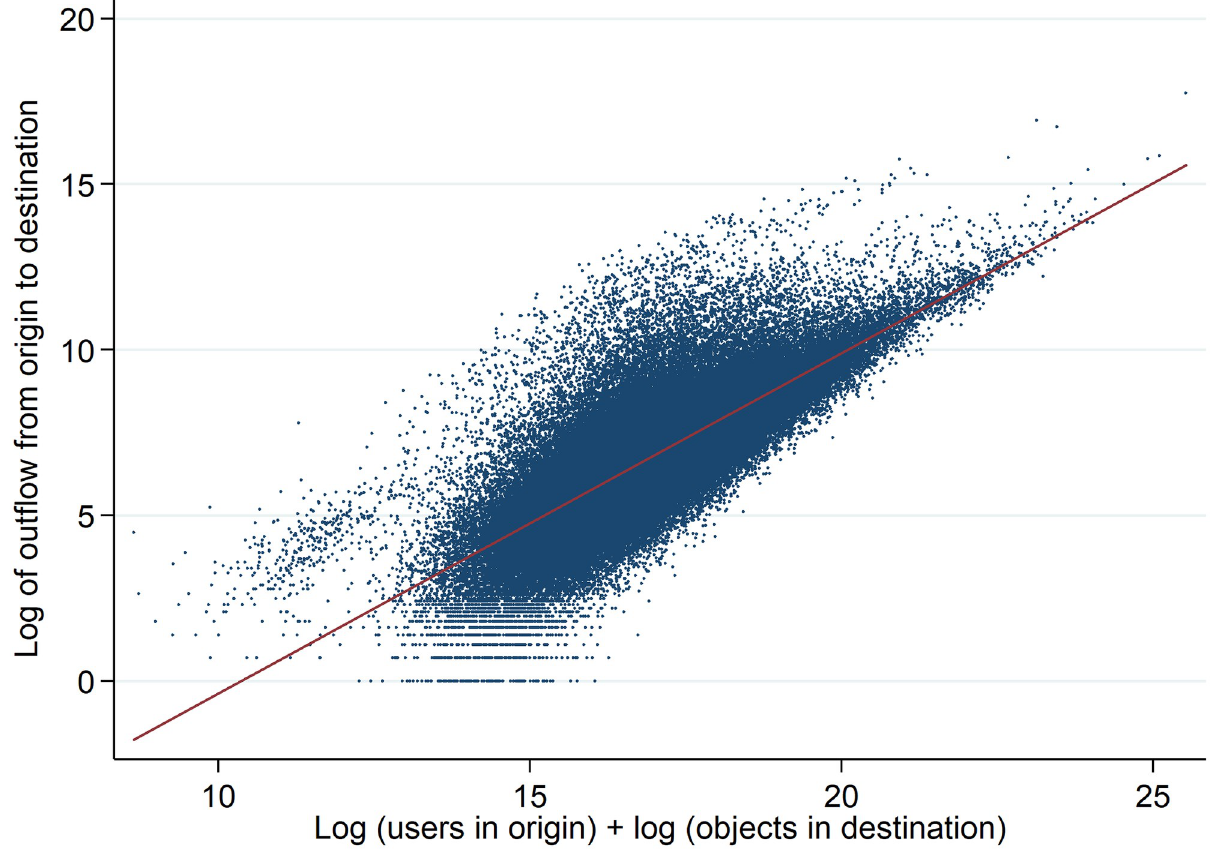
Fig 3. Hit flows between municipalities in relation to